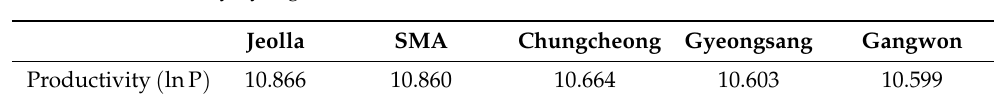
Table 12. Productivity by region.